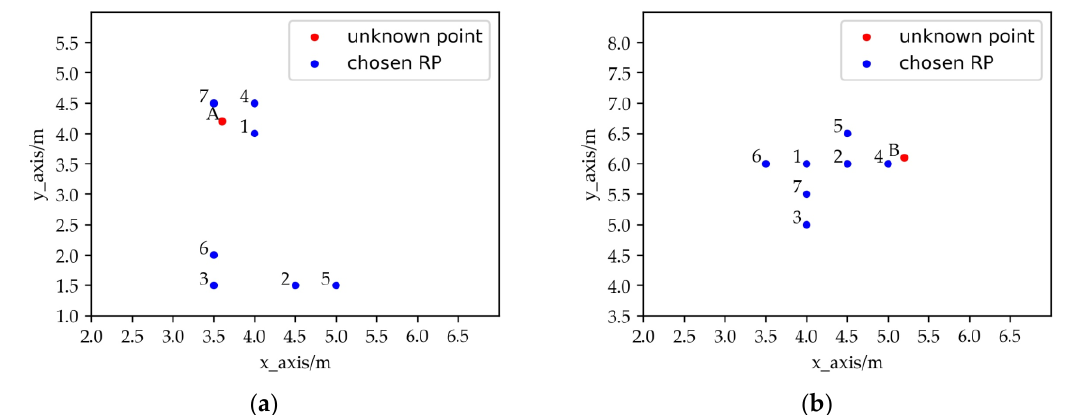
Figure 2. The abnormal distribution of RPs, where some of the selected RPs similar in RSSI to the unknown point is further in ( a ) and the selected RPs similar in RSSI to the unknown point gather on one side in ( b ).